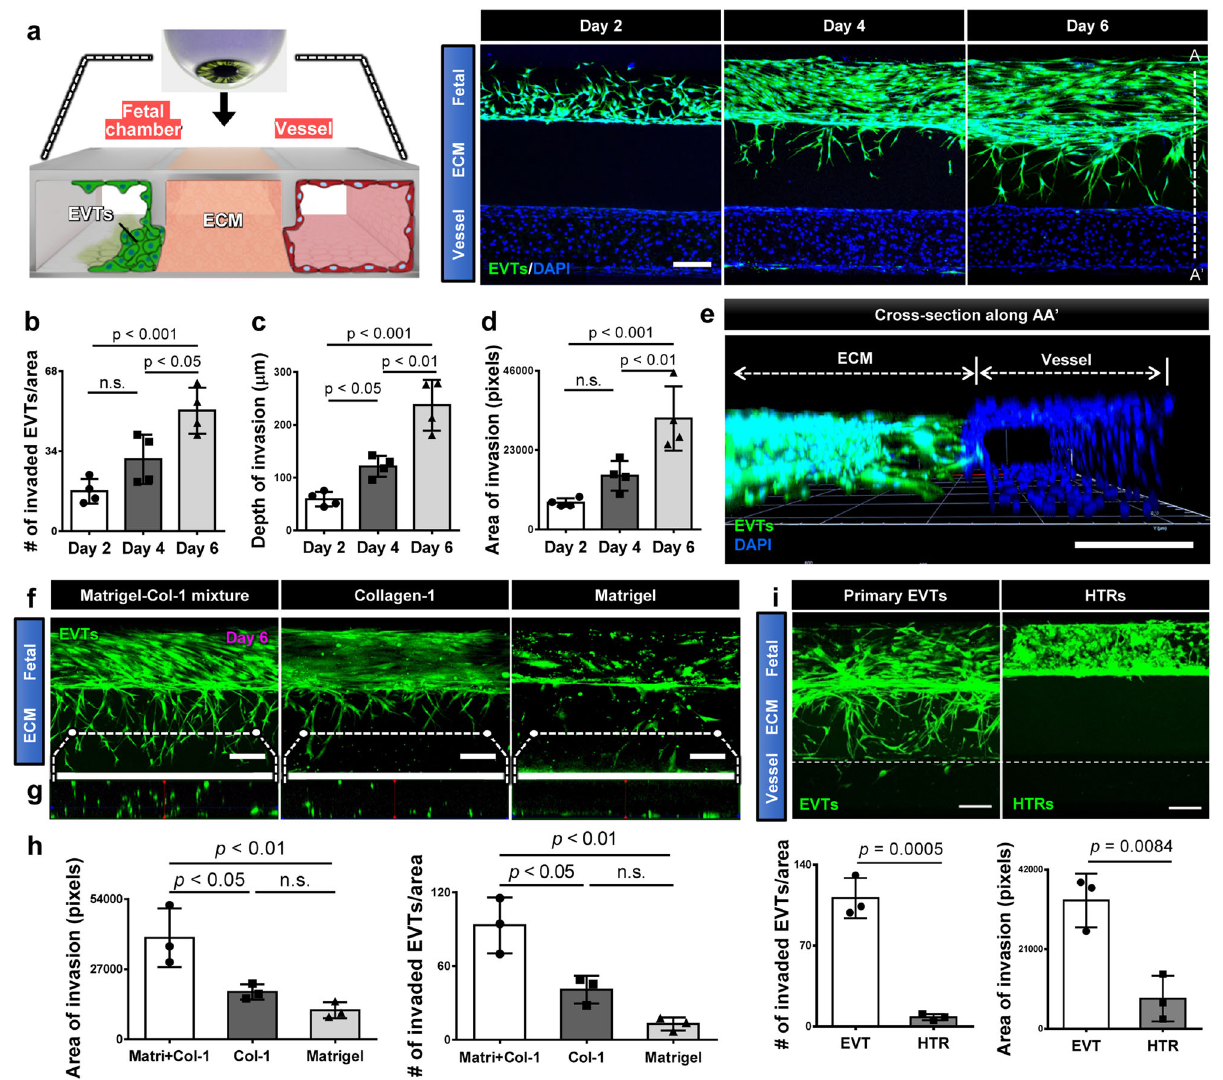
Fig. 2 EVT invasion in the implantation-on-a-chip. a Top-down view of the device containing fetal EVTs and maternal ECs visualized at Days 2, 4, and 6. The representative images are from four independent devices. EVTs were stained with CellTracker Green and DAPI, whereas ECs are shown with DAPI staining alone. Scale bar, 200 μ m. b – d Quanti fi cation of EVT invasion. One-way ANOVA with Tukey ’ s multiple comparison test ( n = 4 independent devices). e Confocal rendering of 3D EVT migration in the ECM scaffold towards the maternal vessel. The representative image is from three independent devices. Scale bar, 200 μ m. f EVT invasion in three ECM conditions. Images were taken at Day 6. Scale bars, 200 μ m. g Cross-sectional view showing 3D distribution of